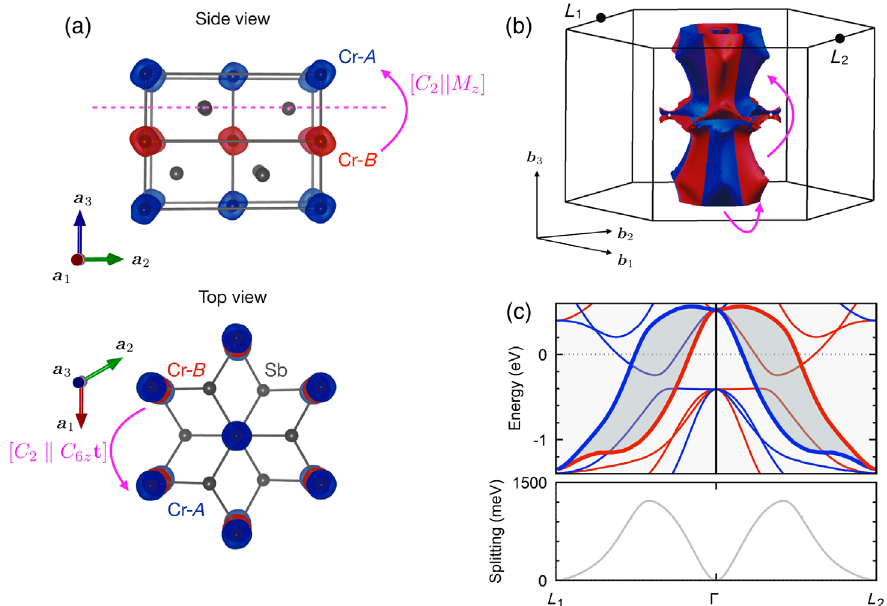
FIG. 4. Metallic high critical temperature CrSb with the third magnetic phase. (a) Schematic crystal structure with DFT spin densities. Cr sublattices and the respective magnetization densities with opposite orientation of the magnetic moment are depicted by red and blue color. Magenta arrow and its label highlights the opposite-spin-sublattice transformation containing a real-space mirror or sixfold rotation. (b) Calculated bulklike spin-momentum locking with the characteristic spin-group integer 4 on top of two selected DFT Fermi surface sheets. (c) DFT band structure in the third magnetic phase. Wave-vector dependence of the spin splitting between the bands highlighted by the gray shading is plotted in the lower